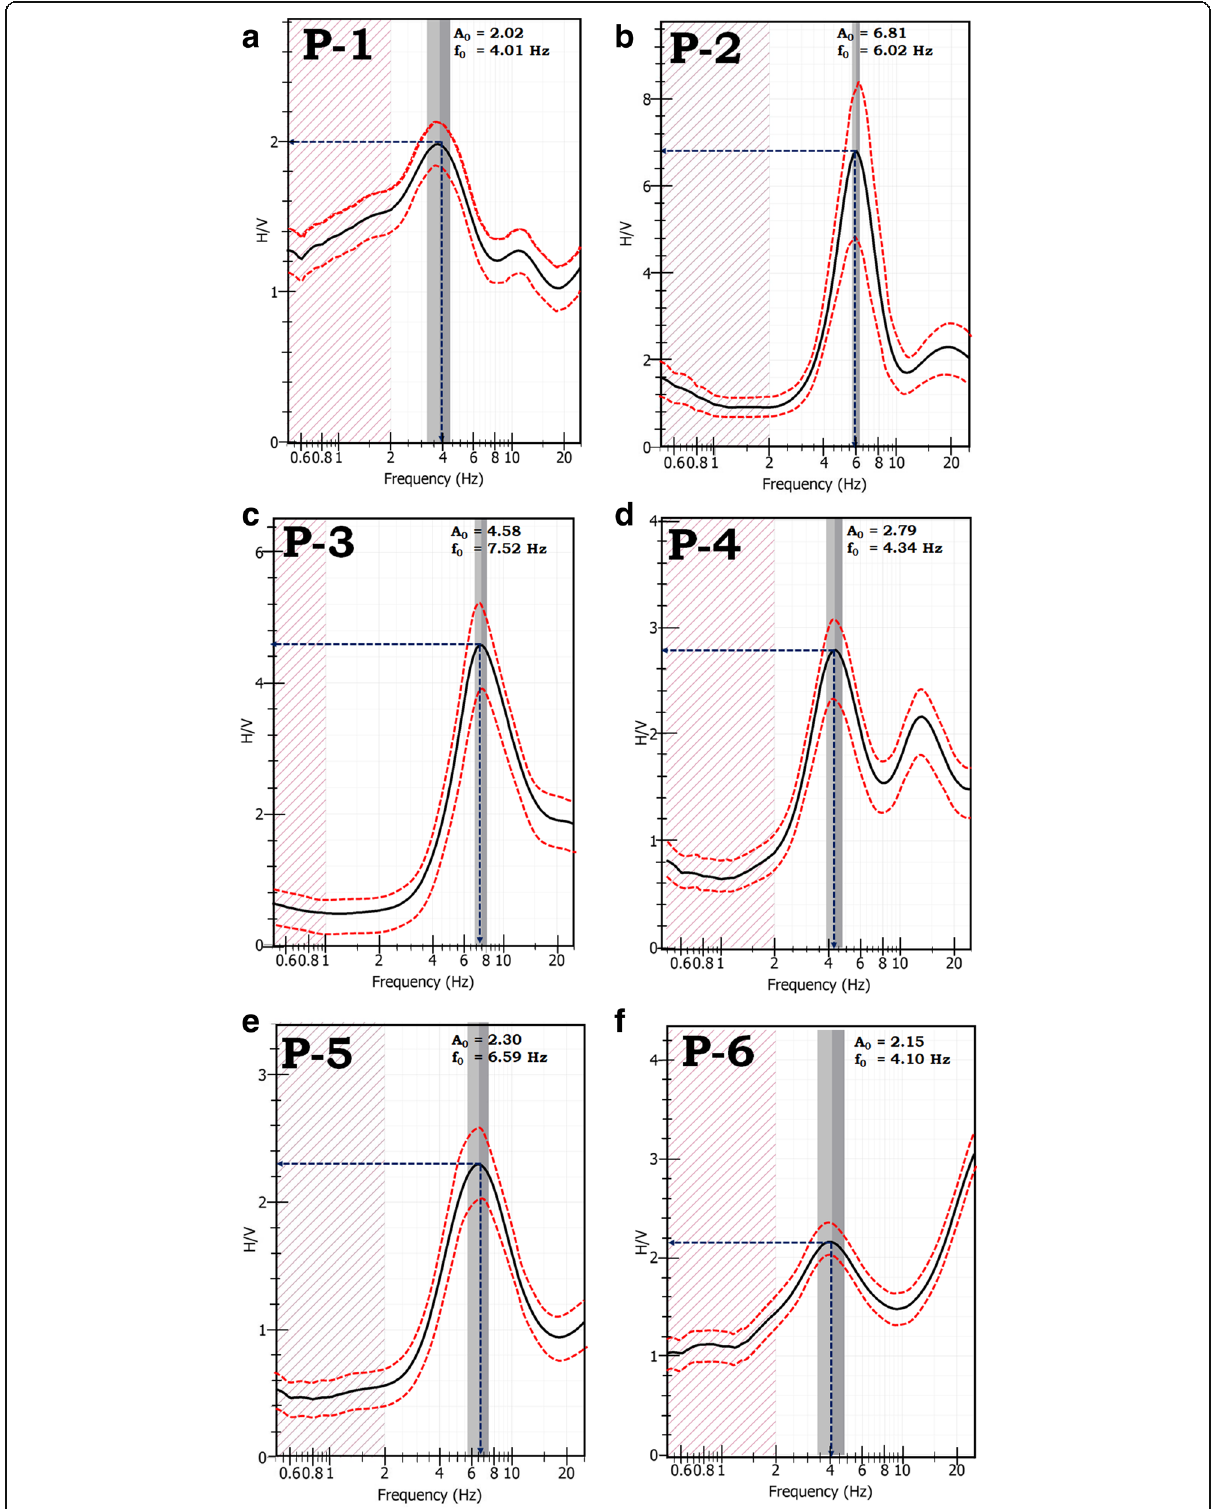
Fig. 5 HV curves at (a) P-1 (b) P-2 (c) P-3 (d) P-4 (e) P-5 and (f)